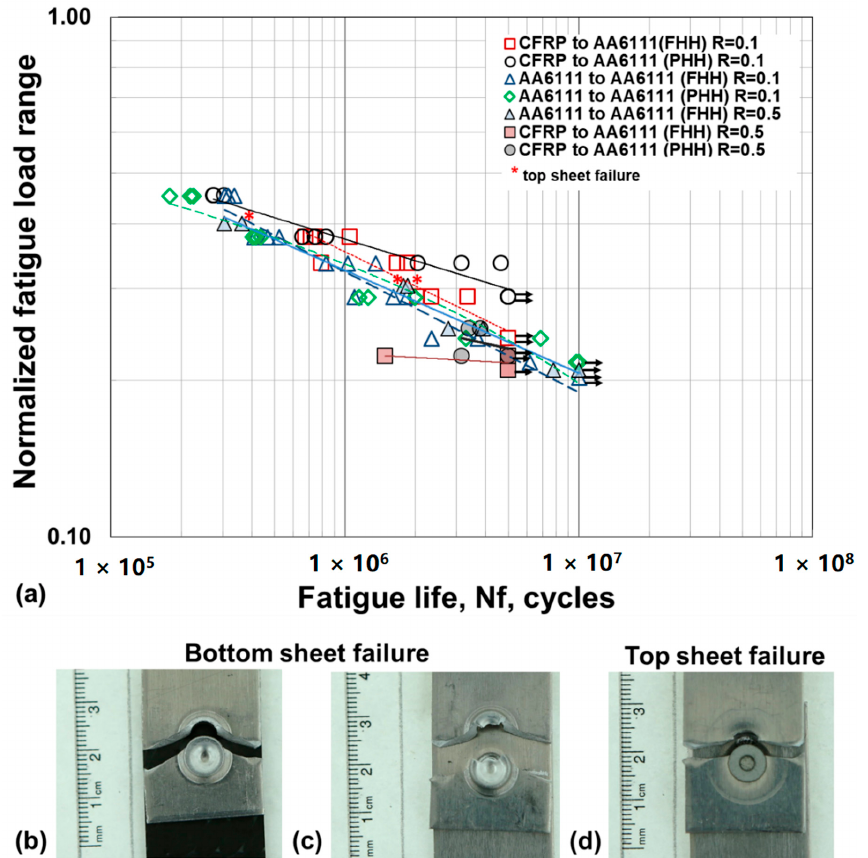
Figure 3. Fatigue load-life curves comparing the fatigue life of CFRP-to-aluminum and aluminum- to-aluminum lap-shear joints (R = 0.1, R = 0.5). Applied fatigue load is normalized to average lap-shear failure load of lap-shear aluminum-to-aluminum SPR joint. Fatigue failure modes observed in ( b ) bottom aluminum sheet fracture in CFRP-to-aluminum SPR joints, ( c ) bottom sheet fracture in aluminum-to-aluminum SPR joints, and ( d ) top sheet fracture in aluminum-to-aluminum SPR joints (the lap-shear SPR joints that fracture in top sheet is indicated in ( a ) with *